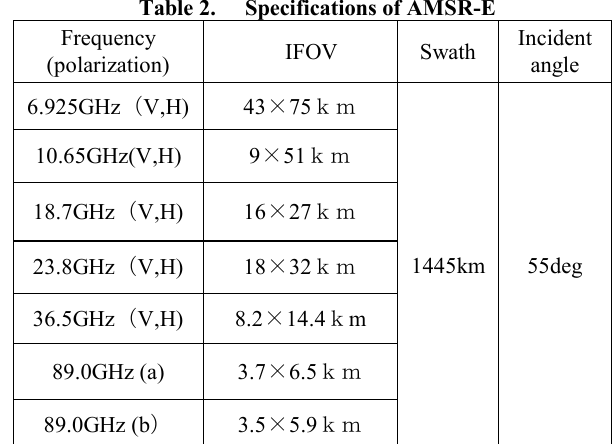
Figure 2. Procedure of direct measurement of ice thickness.